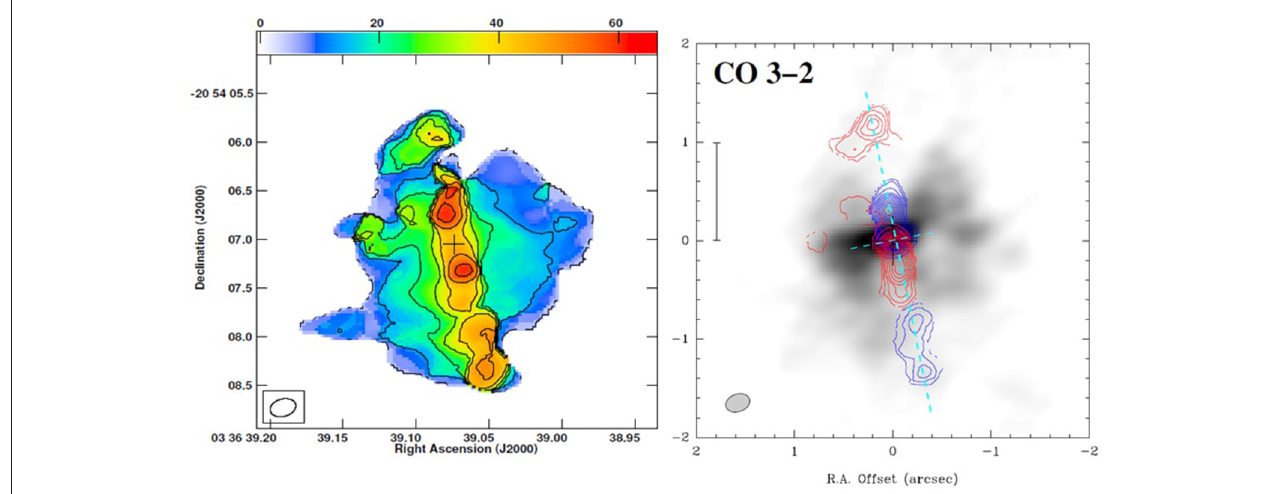
FIGURE 2 | The highly collimated molecular outflow in NGC1377, from Aalto et al. (2016), figure reproduced with permission. The left map is the velocity dispersion, and the right shows the blue and red-shifted CO emission. Note that the velocity of the flow changes sign at mid-way, symmetrically in the North and South.